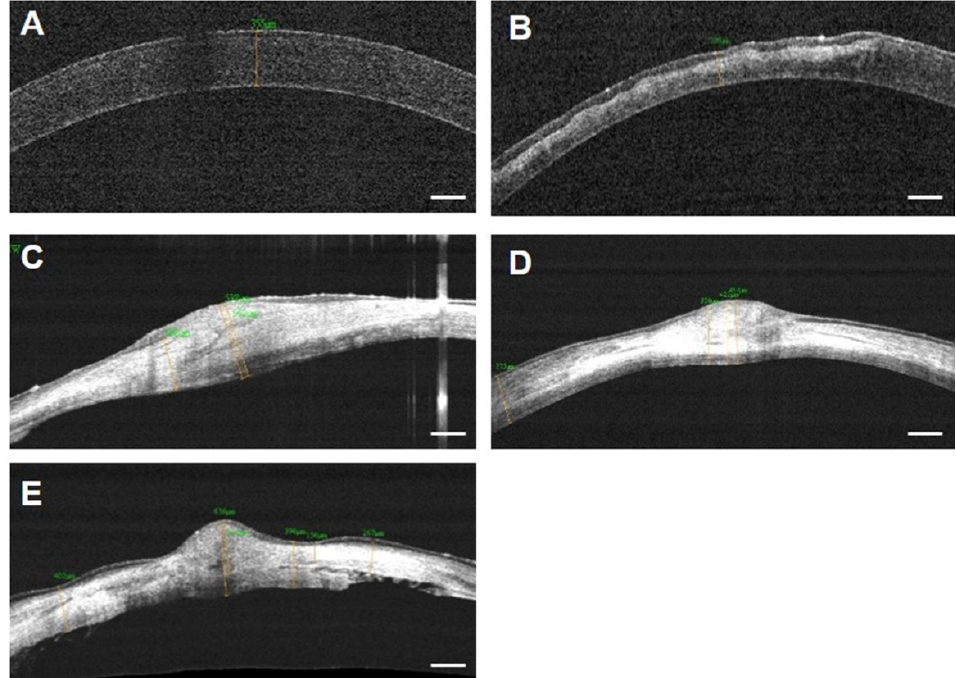
Figure 9. OCT images of all groups at eight weeks after surgery. ( A ) Normal cornea before surgery. ( B ) Group 1. Irregular epithelial and stroma layer indicates incomplete restoration. Full thickness of the central cornea is the least in all groups. ( C ) Group 2. Increased density of stroma is shown in the central area. ( D ) Group 3. Enhanced corneal integrity and intact epithelium are identified. ( E ) PRF group. Stromal surface is irregular, and the border of Descemet’s membrane is indefinite. Thickening of the corneal endothelial cell layer was observed, indicating that the endothelial cell layer was not properly remodeled due to inflammation. Scale bar = 250 µm.